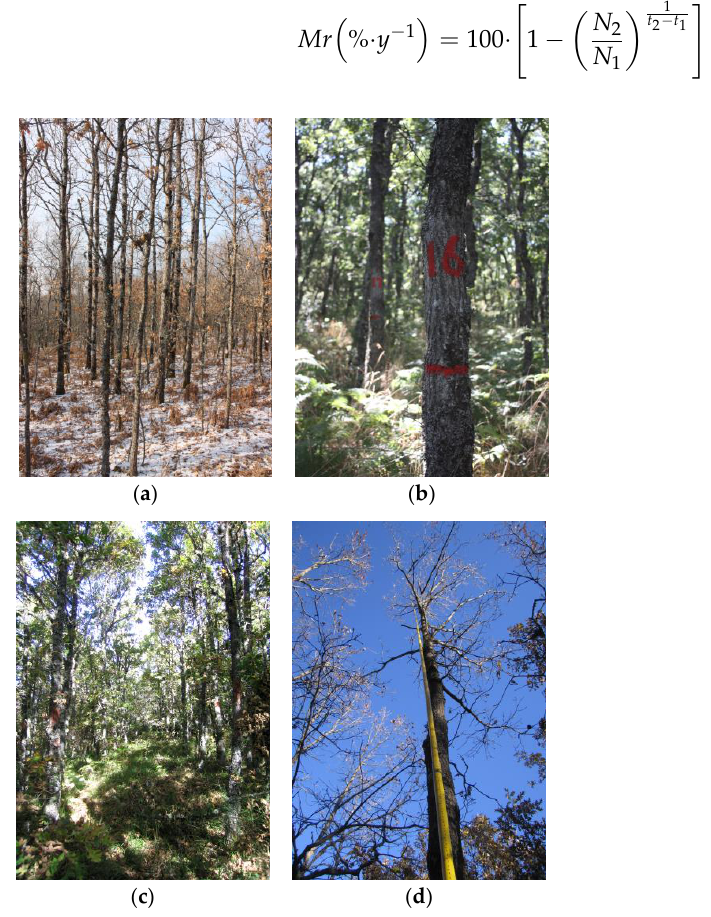
Figure 2. Conversion-of-Pyrenean-oak-coppice research trial. From left to right: overview of control plot ( a ), selective ( b ) and strip cutting ( c ), and tree height measurement ( d ). Images at installation age of 28 years.